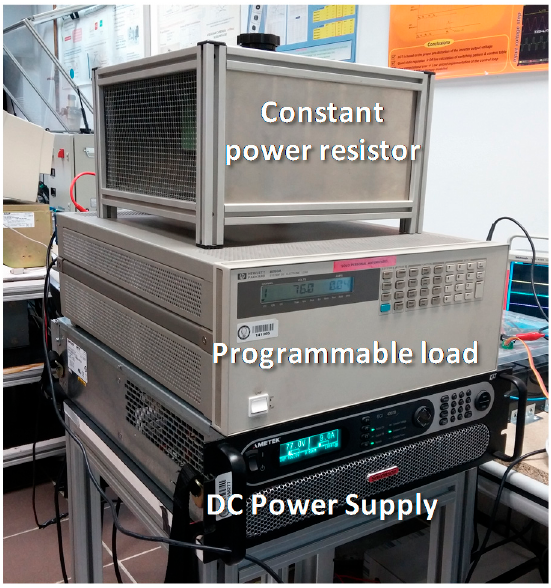
Figure 27. Load system emulator.